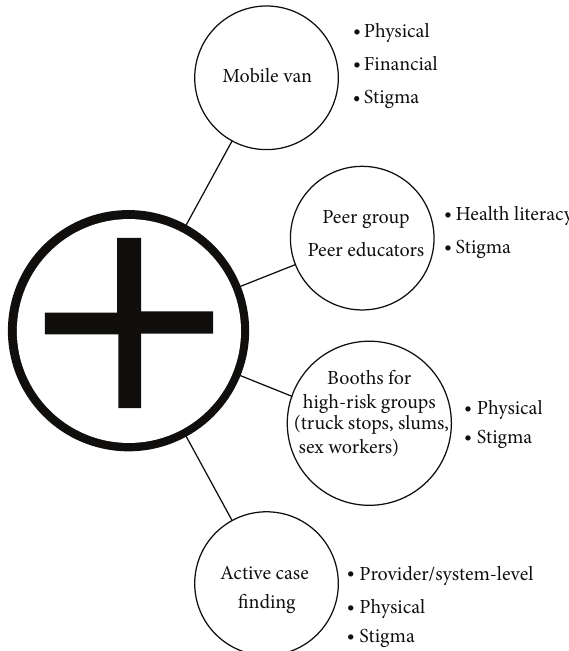
Figure 3: Decentralized model of TB care delivery highlight- ing suggested interventions to target identified barriers. Figure 3 illustrates the transition from the traditional, centralized model of TB care delivery (central circle with the cross), which uses primary, secondary, and tertiary facility-based TB care (including government hospitals as well as community and nongovernmental organizationclinics),toadecentralizedmodelofTBservicedelivery that incorporates several interventions to overcome the individual- level and provider/system-level barriers identified in this review. Suggested interventions are listed with the specific barriers that each may address.